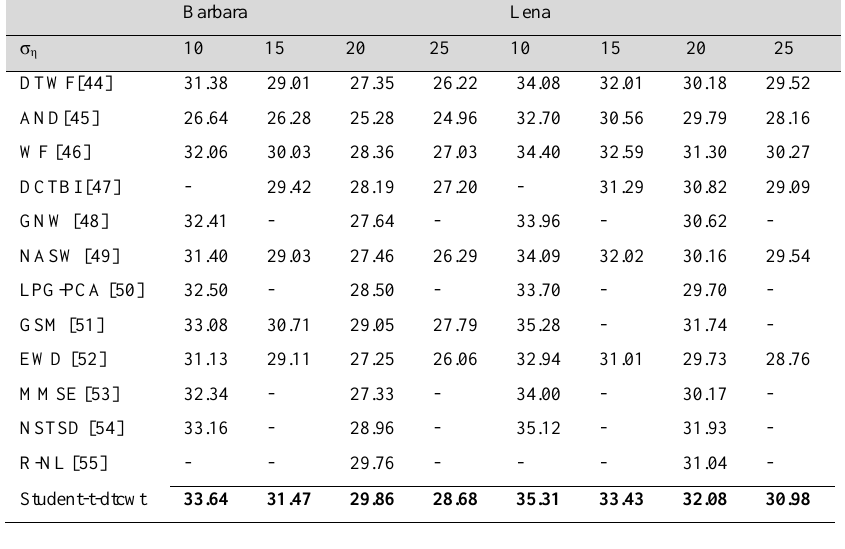
Table 4. PSNR comparison of performance for image denoising using different